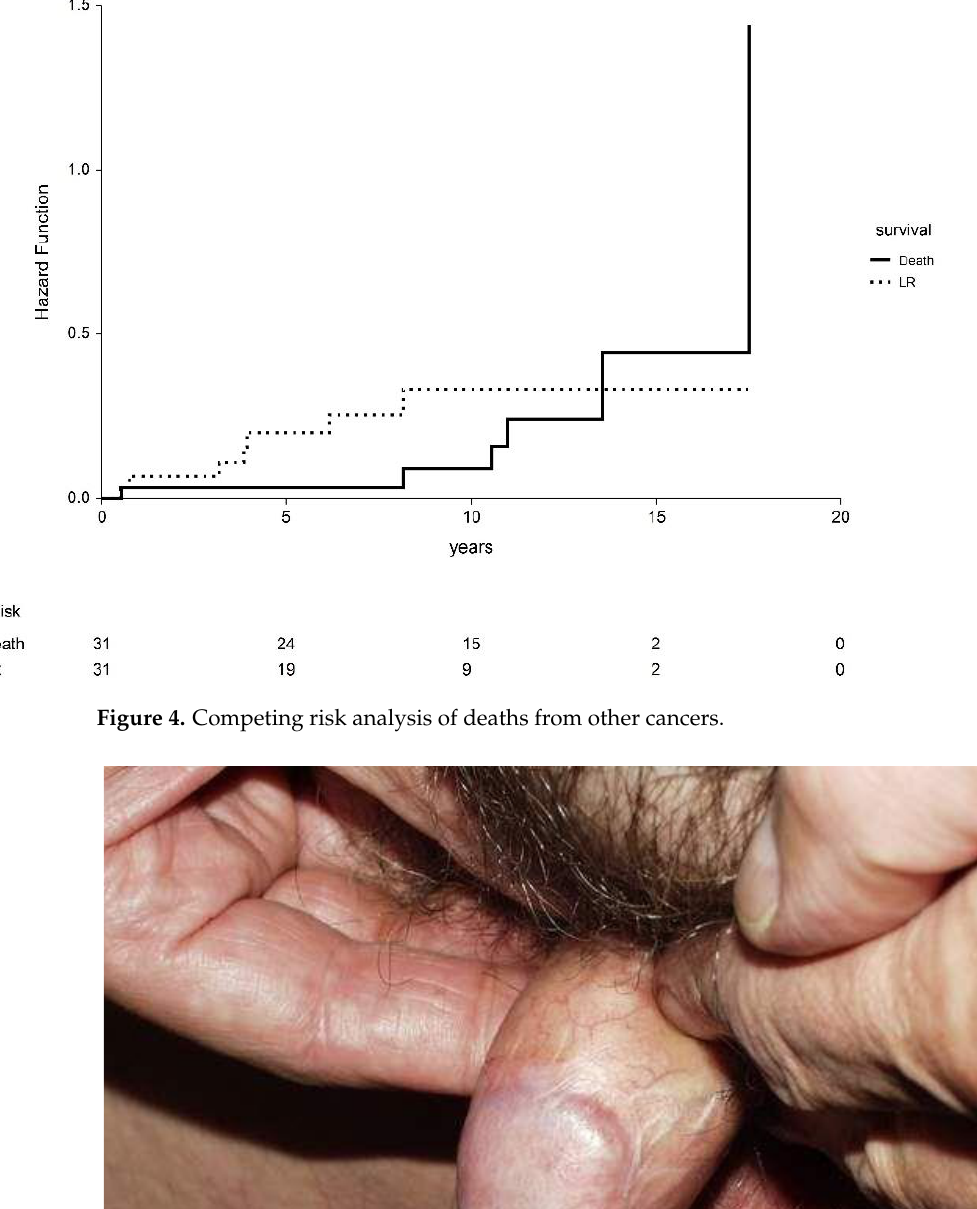
Figure 5. Result at 5 years.